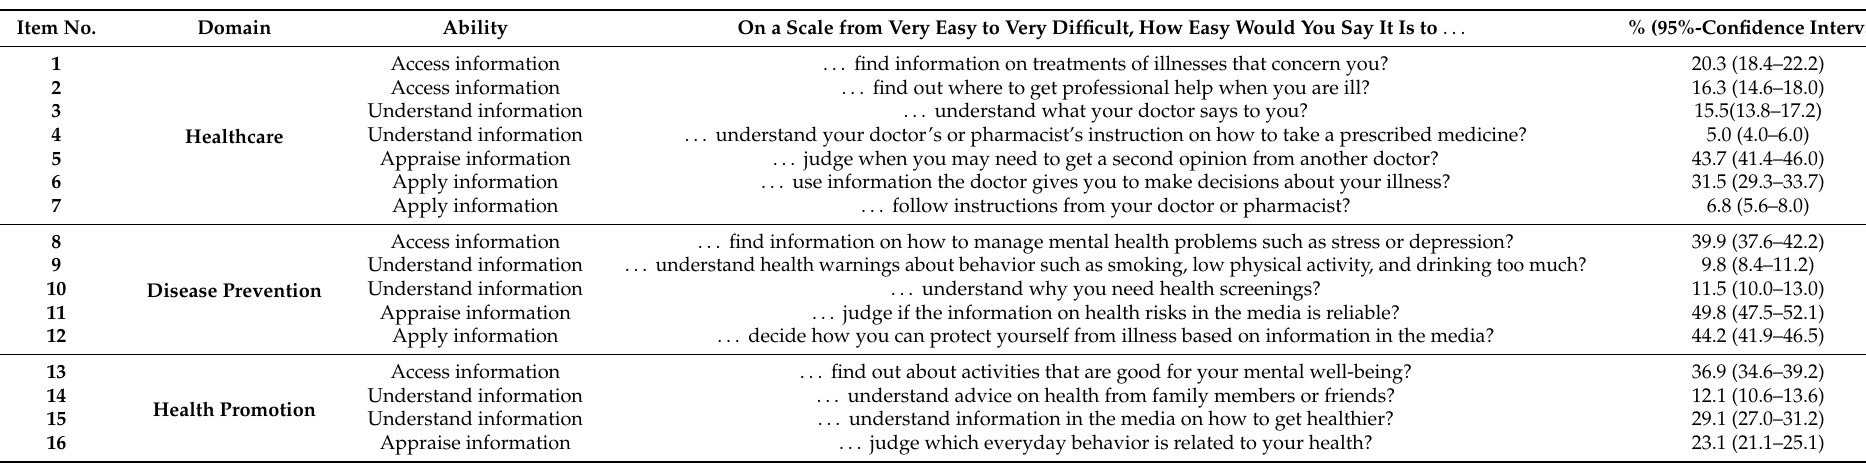
Table 2. Individual items in the HLS-EU-Q16 in relation to the relative frequencies (percentages) for the responses “fairly difficult”/“very difficult” based on Jordan and Hoebel [35]. English translation according to Sørensen et al. [36]. Item